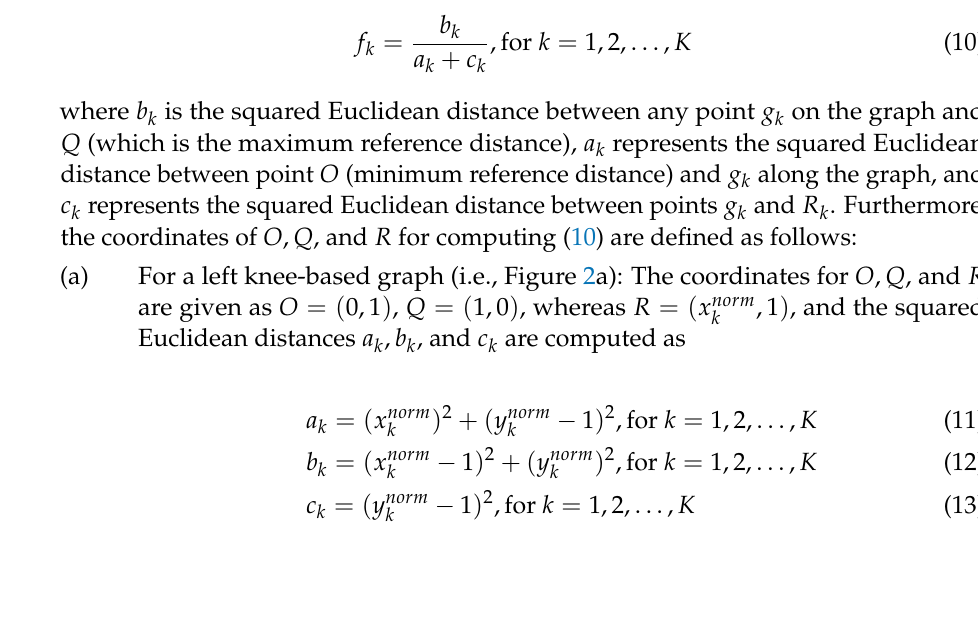
Figure 2. Types of concave graphs corresponding to either elbow- or knee-based graphs: ( a ) Left knee: Concave down with increasing slope, ( b ) Right knee: Concave down with decreasing slope, ( c ) Left elbow: Concave up with decreasing slope, and ( d ) Right elbow: Concave up with increasing slope.